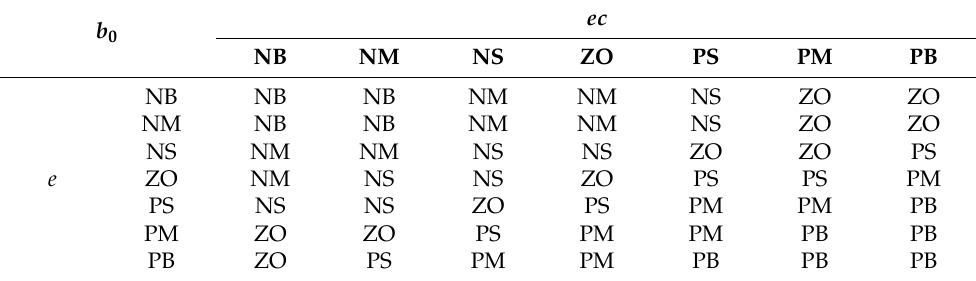
Table 2. Fuzzy rules for b 0